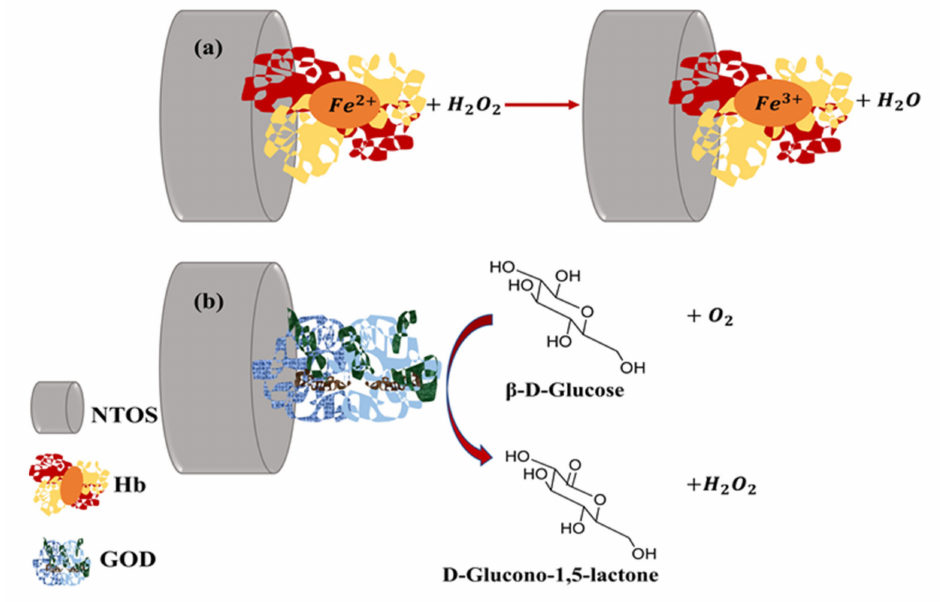
Figure 9. Two typical bioreceptor-analyte reactions of biosensors with a surface consisting of TiO 2 NTs. Reduction of H 2 O 2 catalyzed by the immobilized hemoglobin on the biosensor ( a ) and oxidation of glucose catalyzed by GOD immobilized on the biosensor ( b